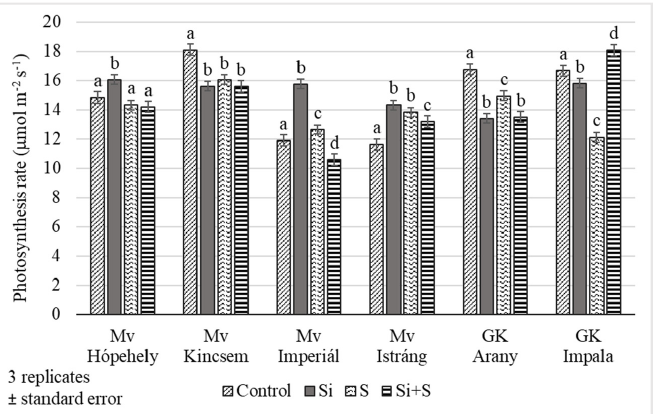
Figure 5. Assimilation rate of winter oat varieties, (Debrecen, 27 May, BBCH52), standard error of means. The different lower-case letters (a–d) mean significant difference at p < 0.05 among the treatments in the varieties. When the letters on the different treatments are the same, it means there is no significant difference between them.